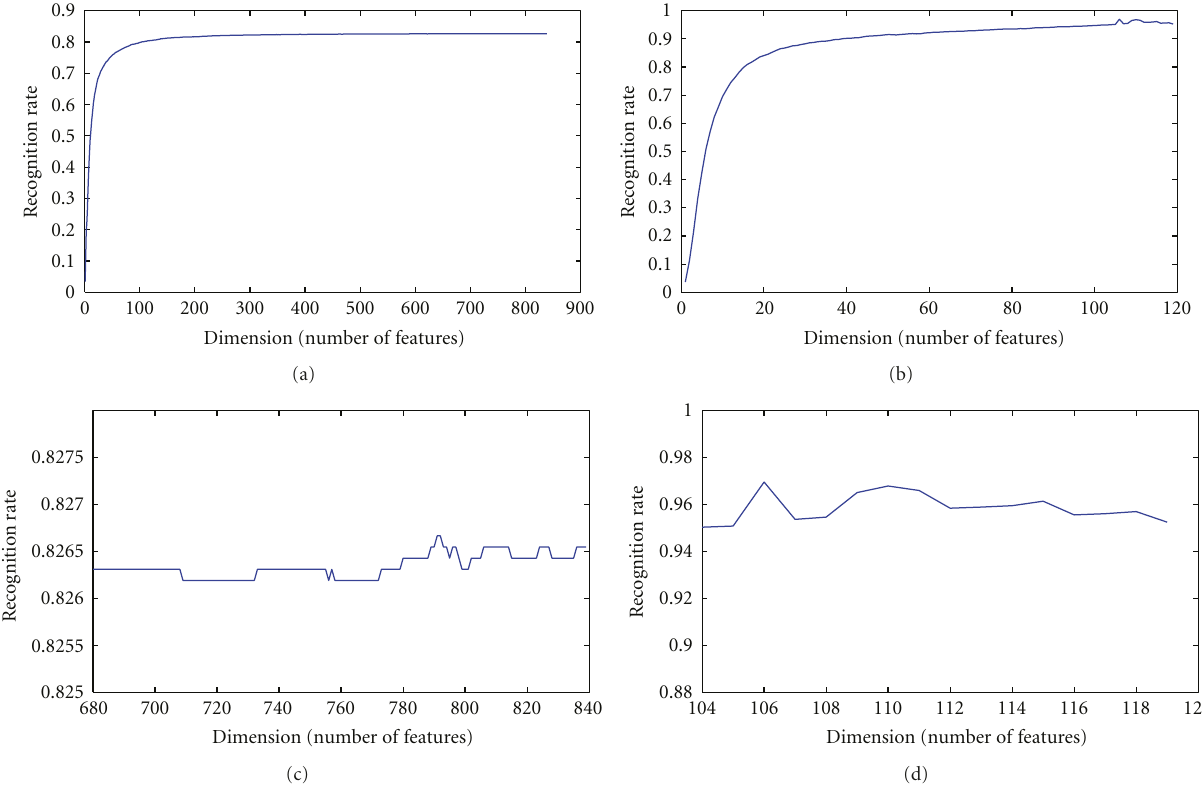
Figure 5: The curves of the average recognition accuracy of (a) Eigenfaces and (b) Fisherfaces on the AR face database versus the number of features or the dimension of feature subspaces. (c) and (d) are the corresponding enlarged last parts of the